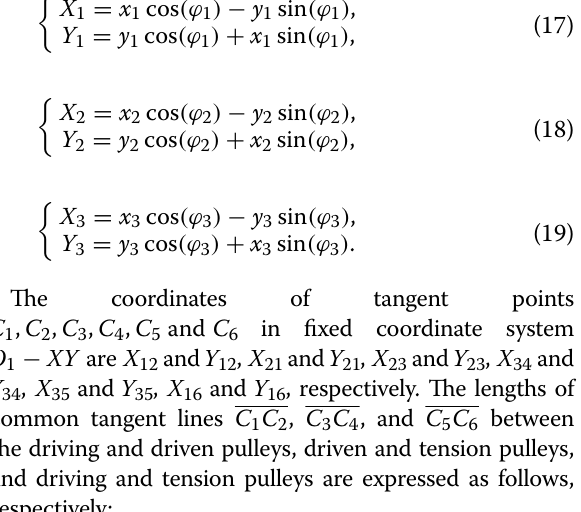
(15), the pitch curves of driving pulley 1, driven pulley 2, and tension pulley 3 in fixed coordinate system O 1 − XY